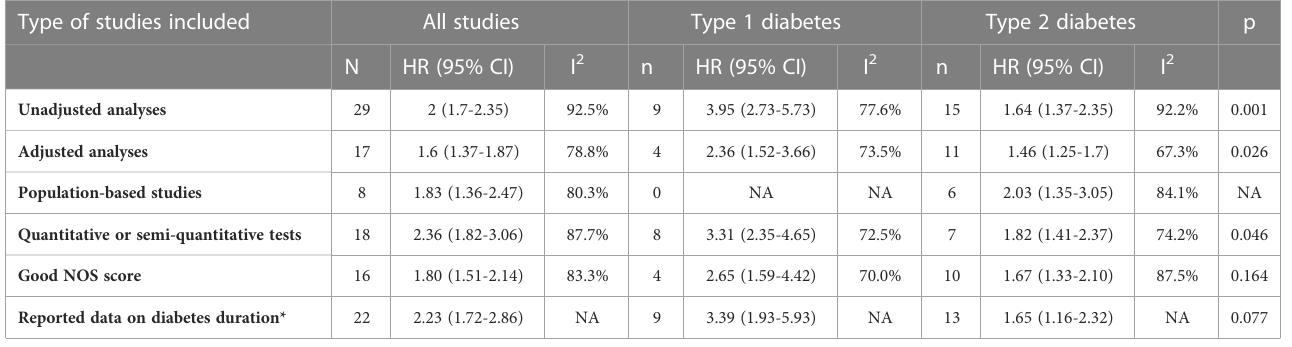
TABLE 2 Association between DSPN and all-cause mortality in sensitivity analyses restricted to cohorts based on adjustment of estimates, study setting, measurement methods, NOS score, and those that reported diabetes duration. Type of studies